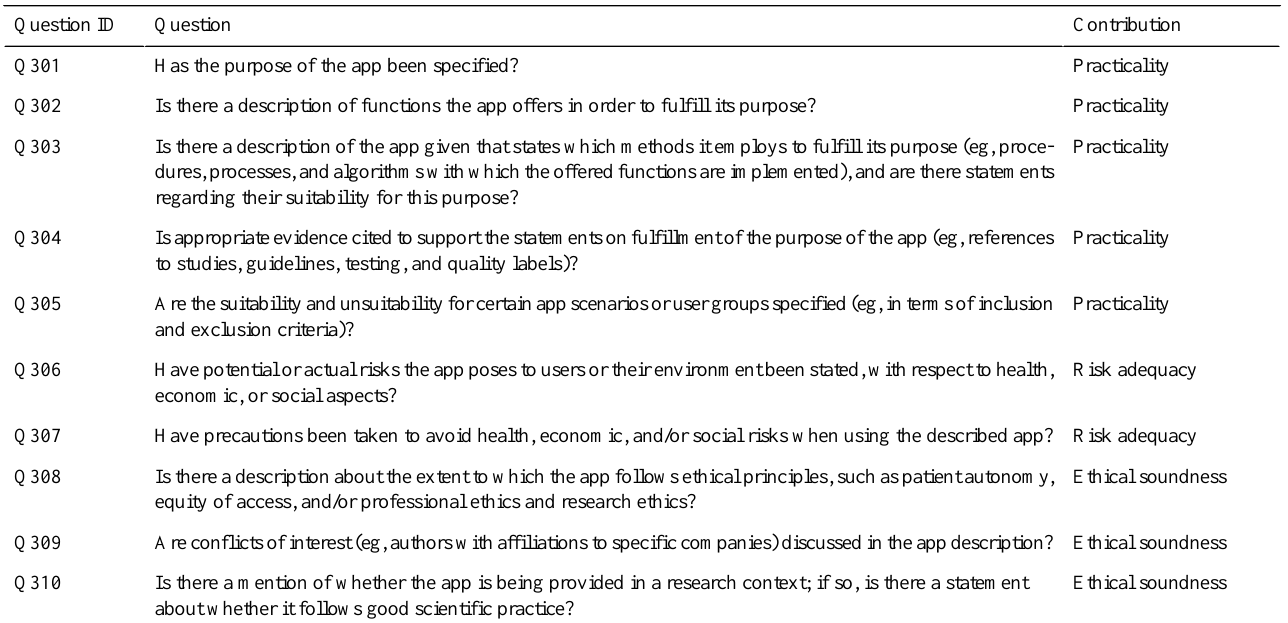
Table 4. Operationalization of the nine quality principles using 25 detailed questions, via Q3 a , according to Albrecht